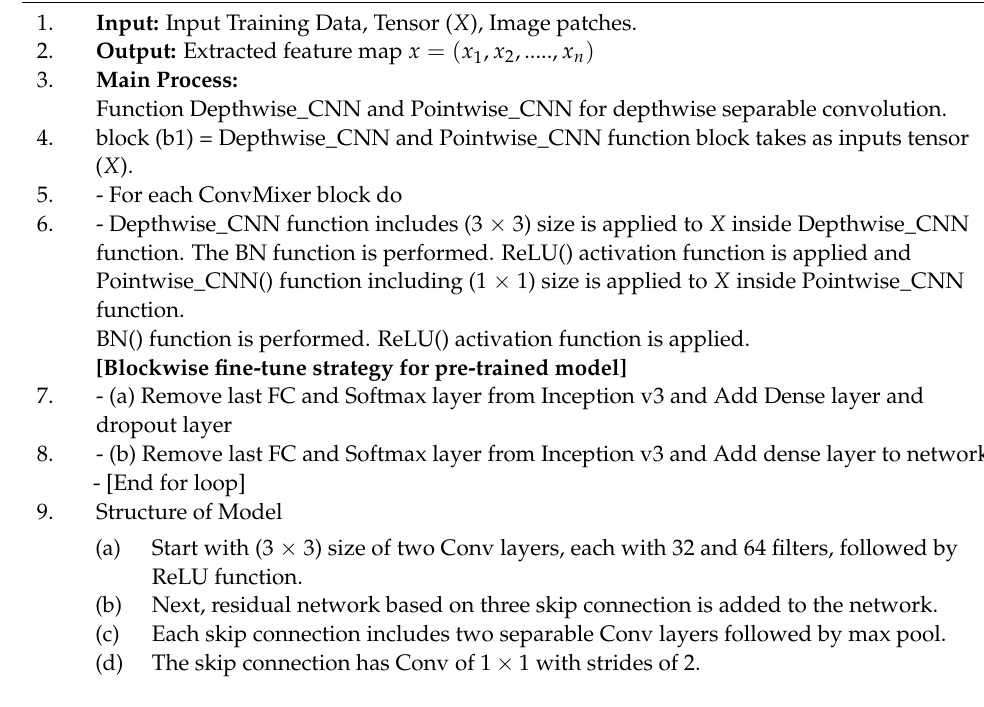
Algorithm 1: Proposed ConvMixer model with fine-tuning for robust feature